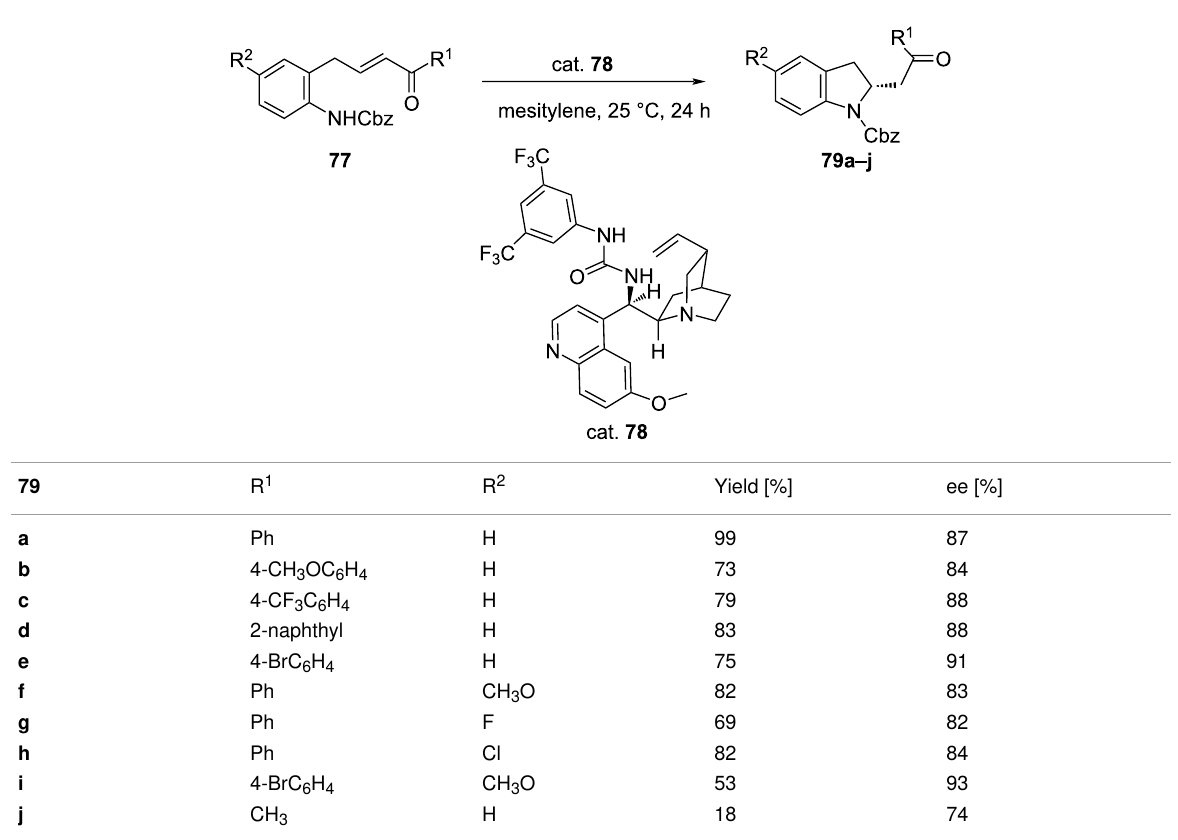
Table 18: Intramolecular aza-Michael addition catalyzed by bifunctional